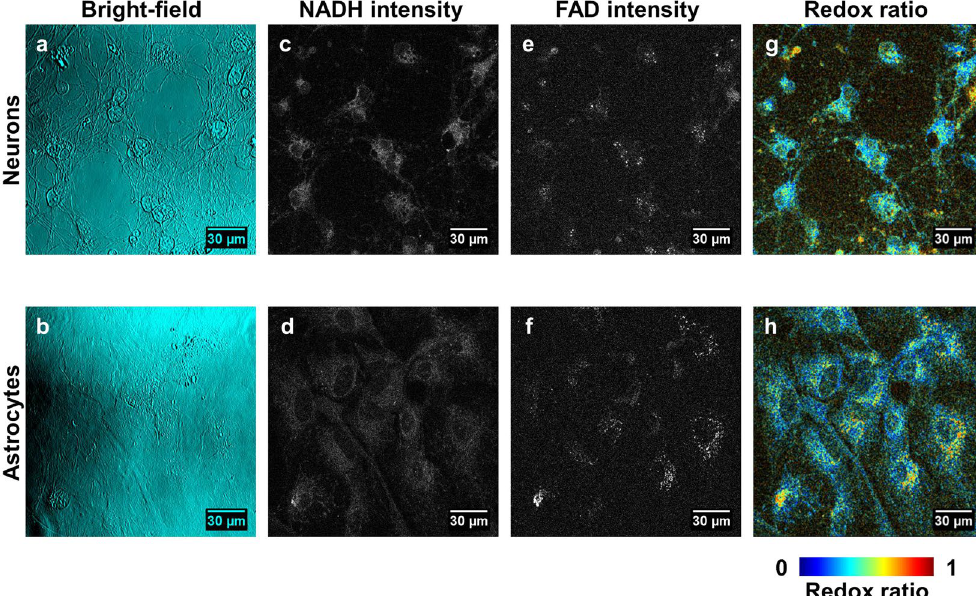
Figure 2. Images of neurons and astrocytes. ( a ) Bright-field images reflect neuron morphology characterized by small cell bodies and highly networked extensions. ( b ) Astrocyte morphology is characterized by a smooth, dense monolayer with spread-out cell bodies. ( c,d ) NAD(P)H fluorescence in neurons ( c ) and astrocytes ( d ) co- localizes with cell bodies. ( e,f ) FAD fluorescence in neurons ( e ) and astrocytes ( f ) localizes closer to the nucleus. ( g,h ) Redox ratio maps of neurons ( g ) and astrocytes ( h ) capture auto-fluorescence